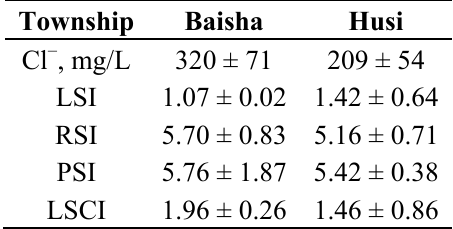
Table 4. Assessment of scaling and corrosion tendency-underground-water quality in Penghu County